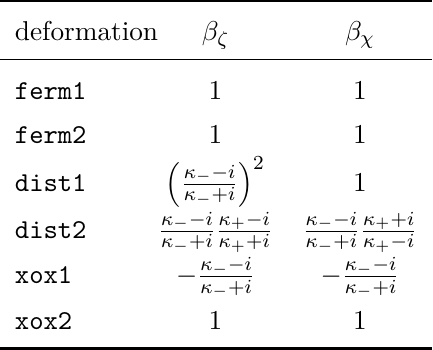
Table 1 : Values for the phases β the kinematic Lagrangians of all six cases take the same form eq.